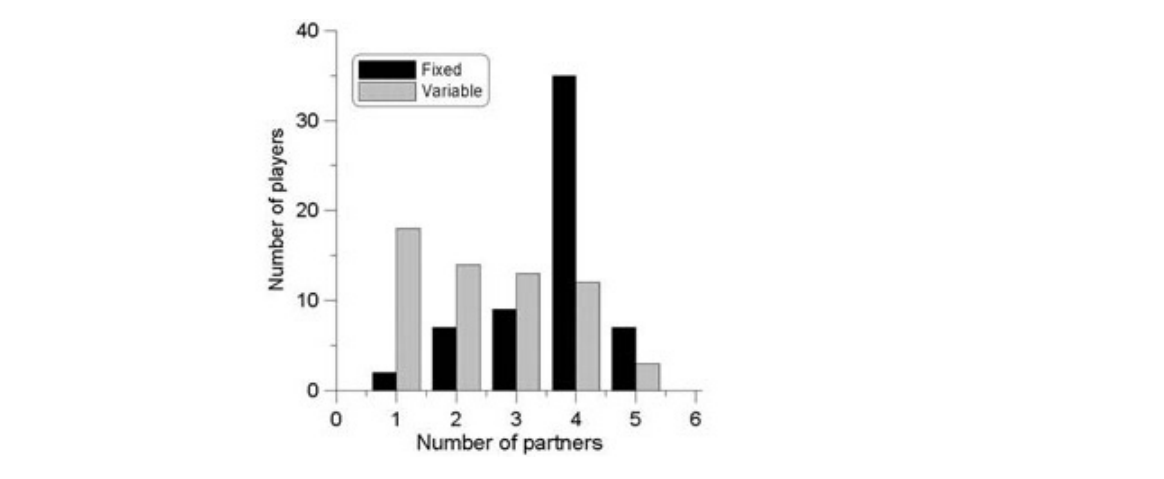
Fig. 3. Distribution (histogram) of the number of partners who interacted over the course of 10 experimental rounds. Black shading represents all 60 players in the ‘fixed’ treatment. Gray shading represents all 60 players in the ‘variable’